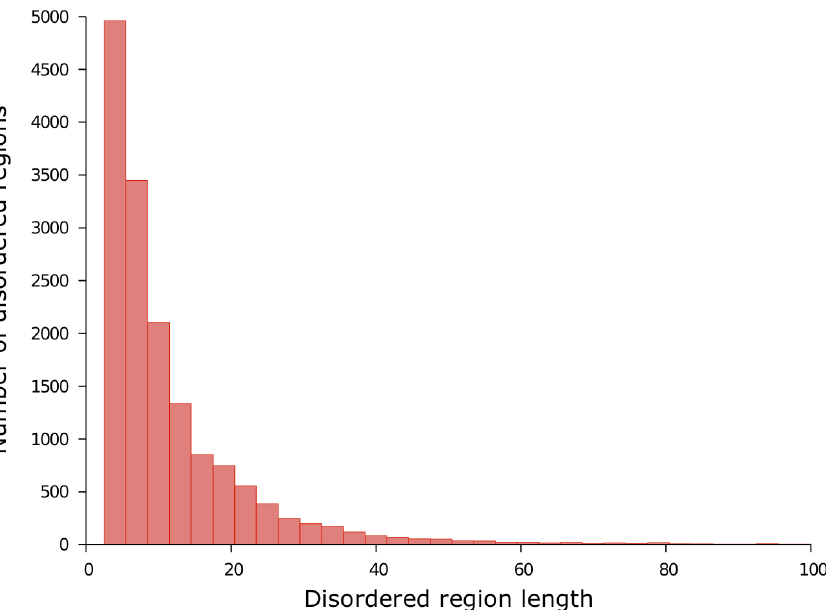
Figure 2. Disordered region length distribution of PDB30. There are 15,726 disordered regions. The average length of a disordered region is of 12.3 residues and the average number of disordered regions per protein is of 1.3.